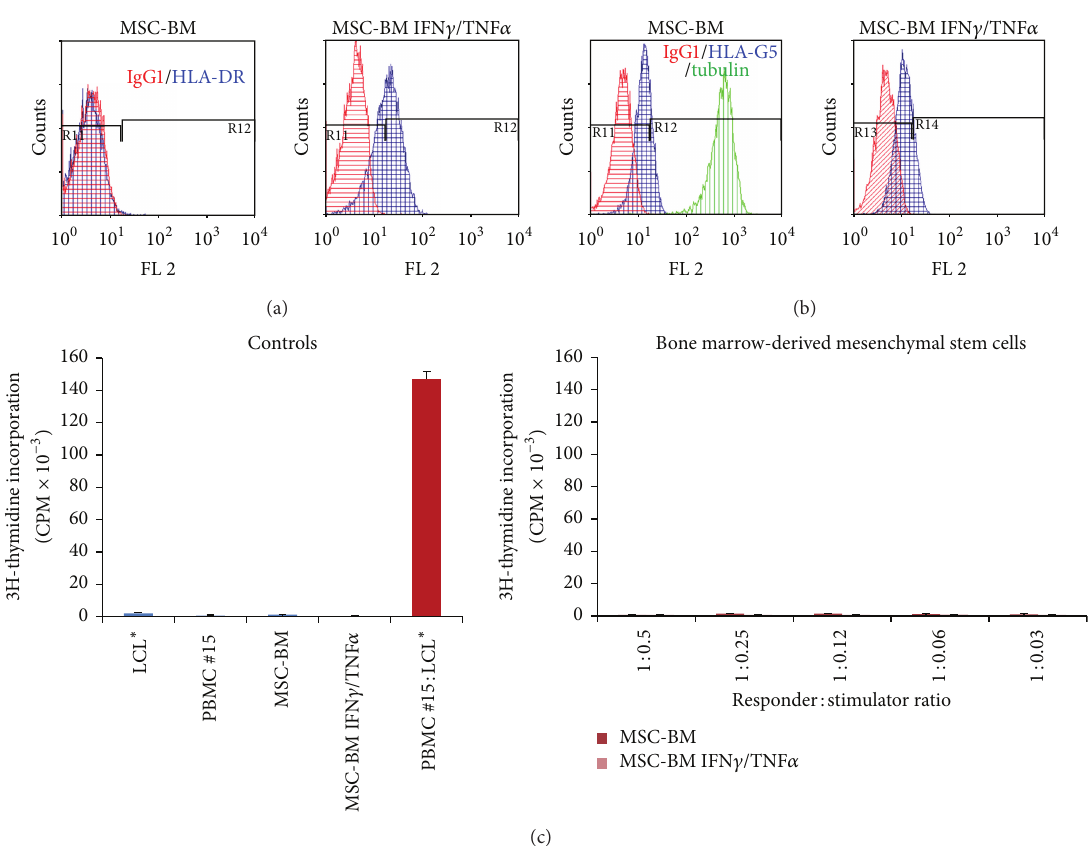
Figure 1: BM-derived MSCs express HLA-G and are hypoimmunogenic. (a) Expression of HLA-DR molecules was evaluated by flow cytometry analysis on BM-derived MSCs pretreated with IFN 𝛾 and TNF 𝛼 (MSC-BM IFN 𝛾 /TNF 𝛼 ) or not (MSC-BM). IgG1 was used as isotype control Ab. (b) Expression of HLA-G5 was evaluated by intracellular flow cytometry analysis on BM-derived MSCs pretreated with IFN 𝛾 and TNF 𝛼 (MSC-BM IFN 𝛾 /TNF 𝛼 ) or not (MSC-BM). Tubulin was used as positive control of cell permeabilization. (c) PBMC from healthy individual (#15) were used as responder cells towards BM-derived MSCs pretreated with IFN 𝛾 and TNF 𝛼 (MSC-BM IFN 𝛾 /TNF 𝛼 ) or not (MSC-BM) as stimulating cells at various responder :stimulator ratios. Irradiated LCL ∗ were used as positive control of T cell alloproliferation. Results are given as mean cpm ± s.e.m.; one representative experiment is